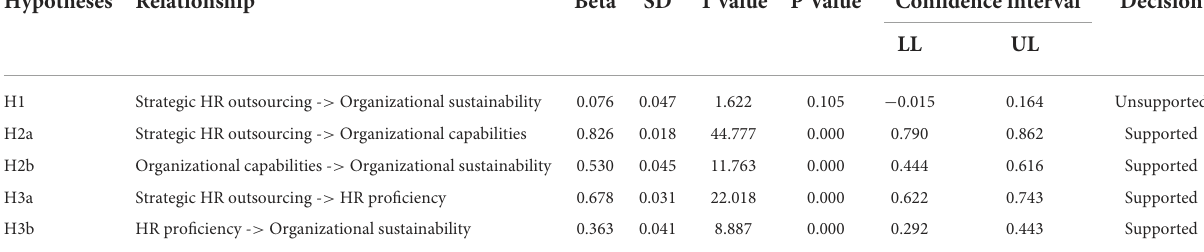
TABLE 7 Direct effects.